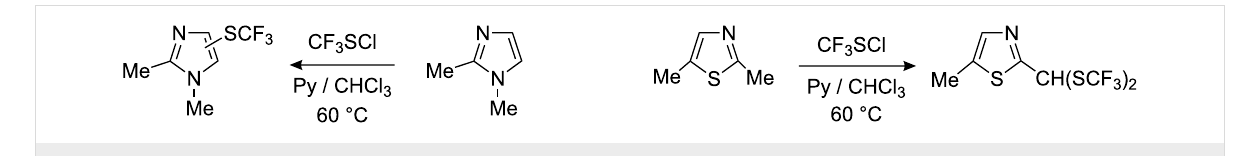
Scheme 18: Trifluoromethylsulfanylation of imidazole and thiazole derivatives